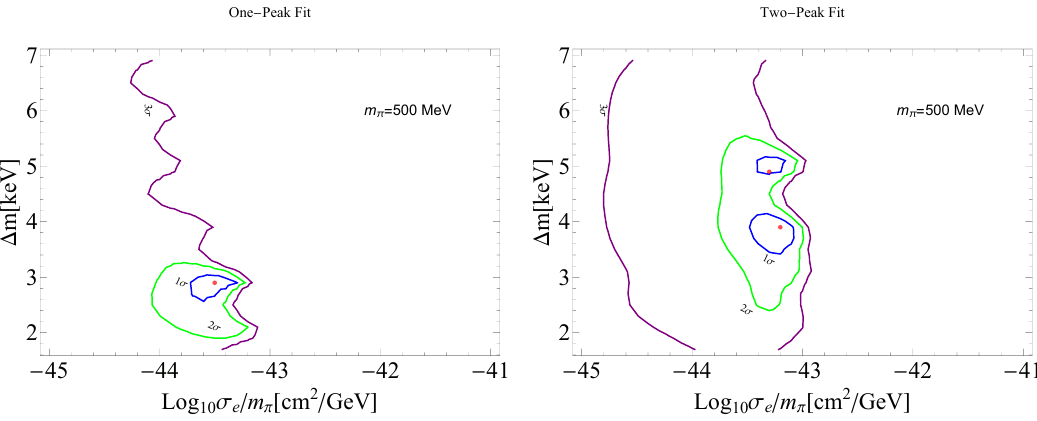
Figure 3 . The minimum χ 2 fit to XENON1T data in the parameter space for ∆ m (in keV) vs ¯ σ e /m ˜ π (in cm 2 / GeV ), for the case with one peak on left and the case with two peaks on right. Blue, green and purple lines indicate 1 σ, 2 σ and 3 σ contours from the minimum χ 2 , respectively. The best- fit points with local minimum χ 2 is shown in red. Dark meson masses are fixed to m ˜ π = 500 MeV , but the results are insensitive to other values as far as m ˜ π > 10 MeV